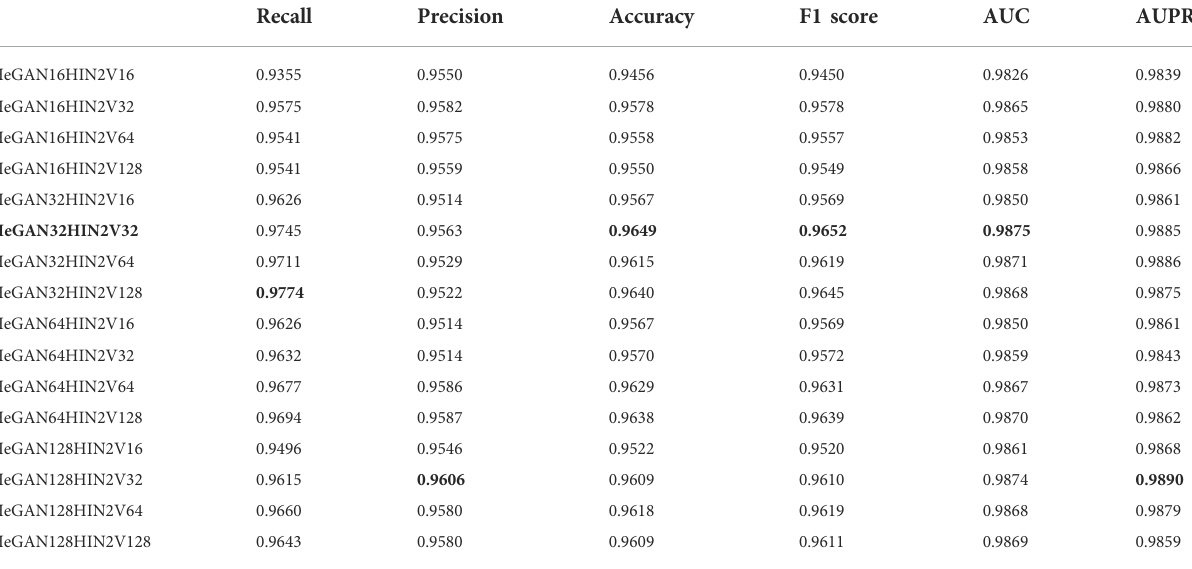
TABLE 3 The six evaluation metrics results of different vector